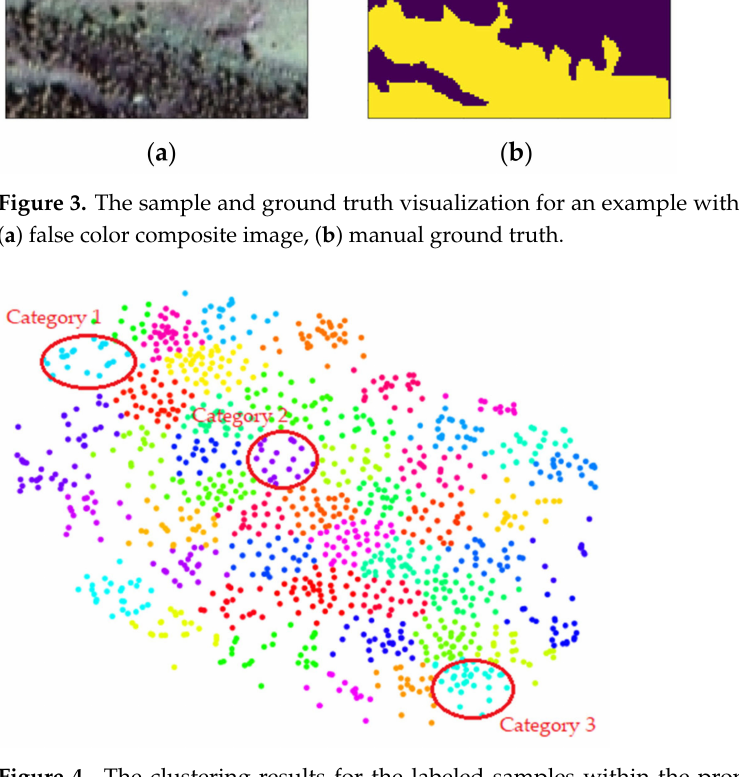
Figure 4. The clustering results for the labeled samples within the proposed dataset: each dot represents a labeled sample; each red circle represents a random selected category, and has been further visualized by false color images in Figure 5.